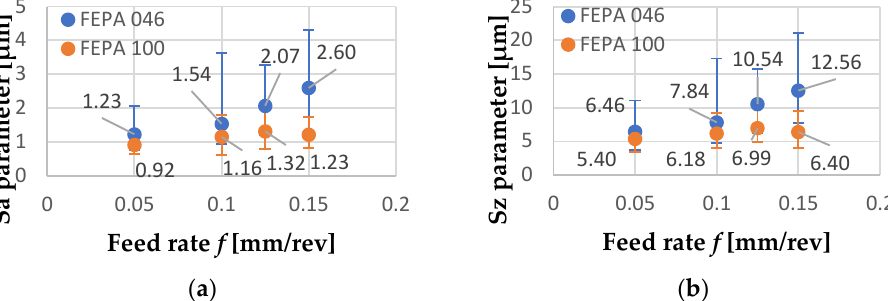
Figure 17. Results of machined surface roughness measurements (arithmetic average): ( a ) Sa pa- rameter and ( b ) Sz parameter (exact values are given next to the bars).